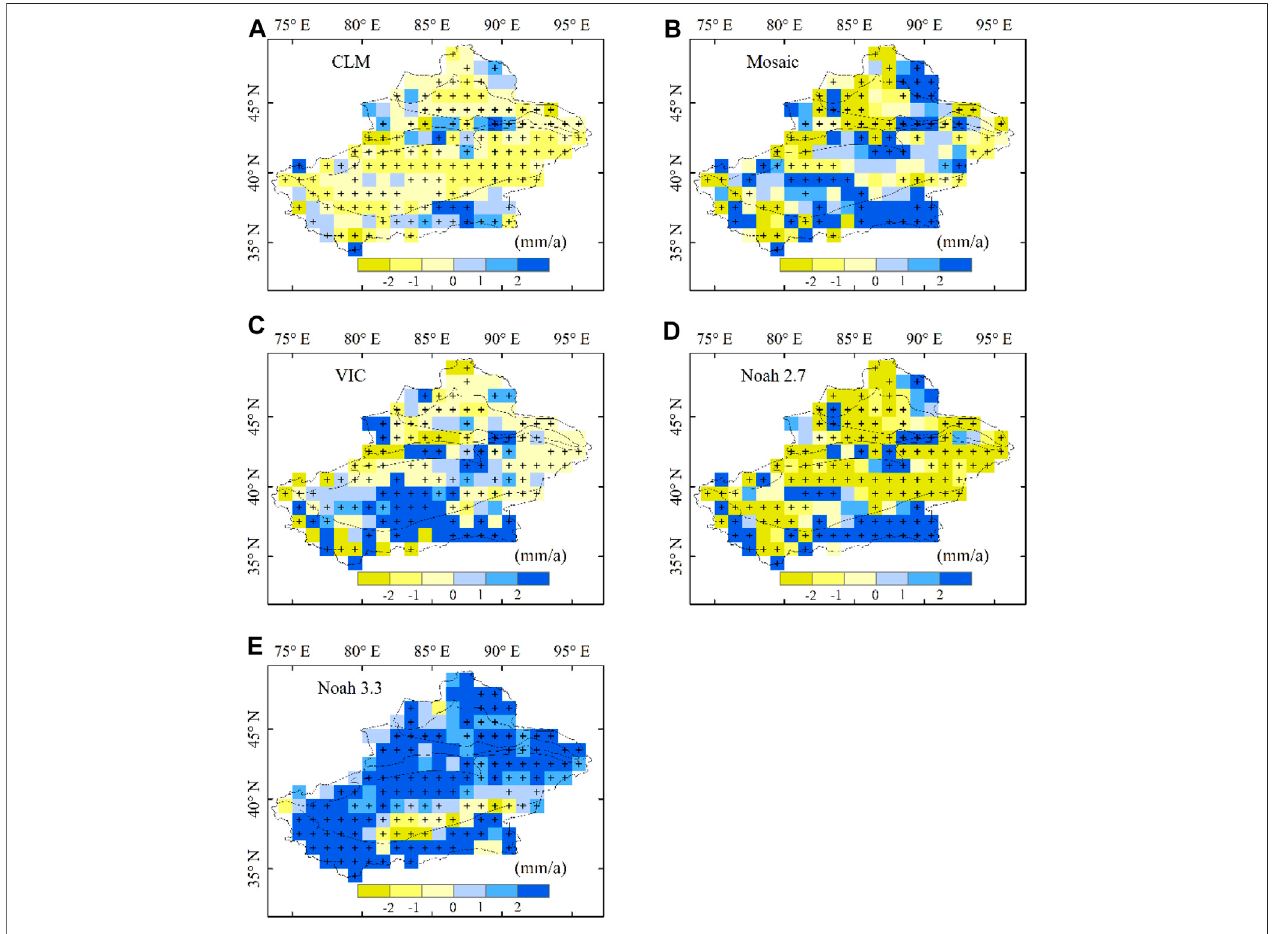
FIGURE 7 | Same as Figure 4 , but for JJA soil